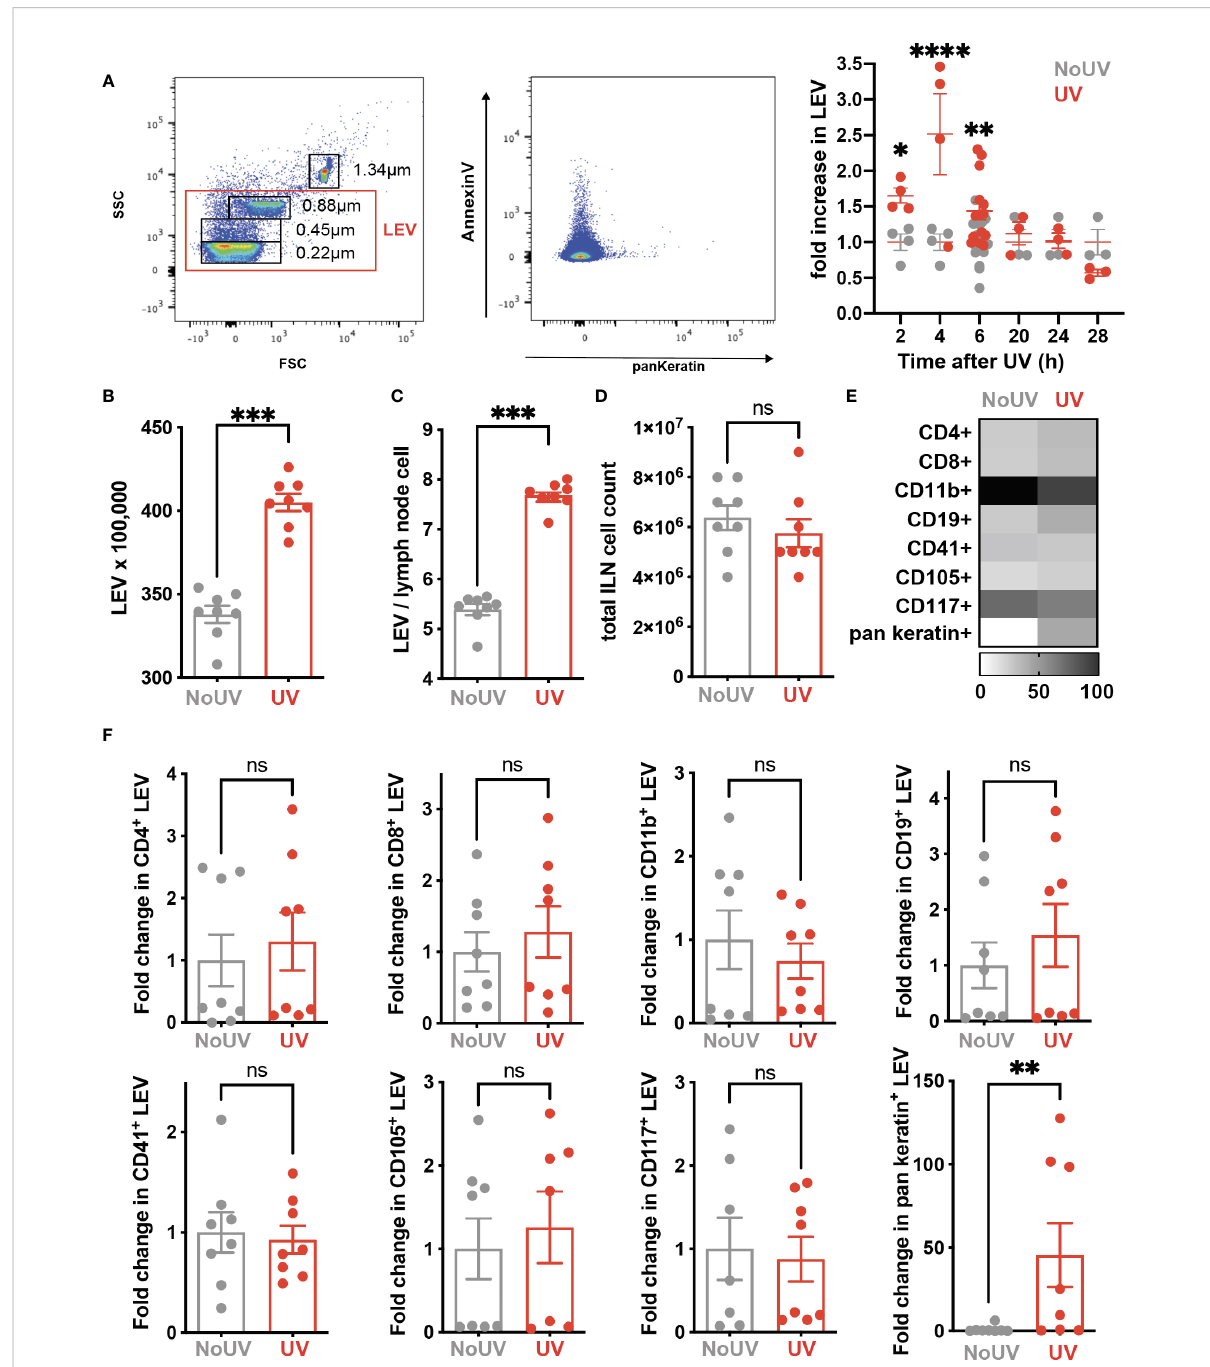
FIGURE 5 iLN LEV are increased at early but not late timepoints post UV exposure. (A) At the times indicated, or at 6h post UV, inguinal lymph nodes (iLN) were isolated and LEV isolated and analysed by fl ow cytometry. LEVs were gated using size beads (0.22, 0.45, 0.88, 1.34µm) to select particles 0.1-1 m m (left plot), with a representative plot showing Keratin + LEVs (right plot). Fold increases in total iLN LEVs at 2, 4, 6, 20 and 24h post UV. At 6h post UV, total iLN LEVs were analyzed as (B) x100, 000 and (C) per iLN cell, calculated from (D) total iLN cell count. (E) Heatmap summarises changes in parent LEVs displayed as minimum-maximum percentile scaling where 100 is the maximum for each marker. (F) Each point represents an individual mouse UV-exposed (red) or not (grey). ‘ Parent ’ cell speci fi c LEVs from T cells (CD4 + and CD8 + ), B cells (CD19 + ), monocyte/macrophages (CD11b + ), platelets (CD41 + ), endothelial cells (CD105 + ) mast cells (CD117 + ) and keratinocytes (pan-keratin + ) were assessed as fold change of absolute numbers x100,000. Statistical analysis was by a 2-way ANOVA with an uncorrected Fisher ’ s LSD or Mann- Whitney test. *p< 0.05, **p< 0.01, ***p< 0.001, ****p<0.0001; ns, not signi fi